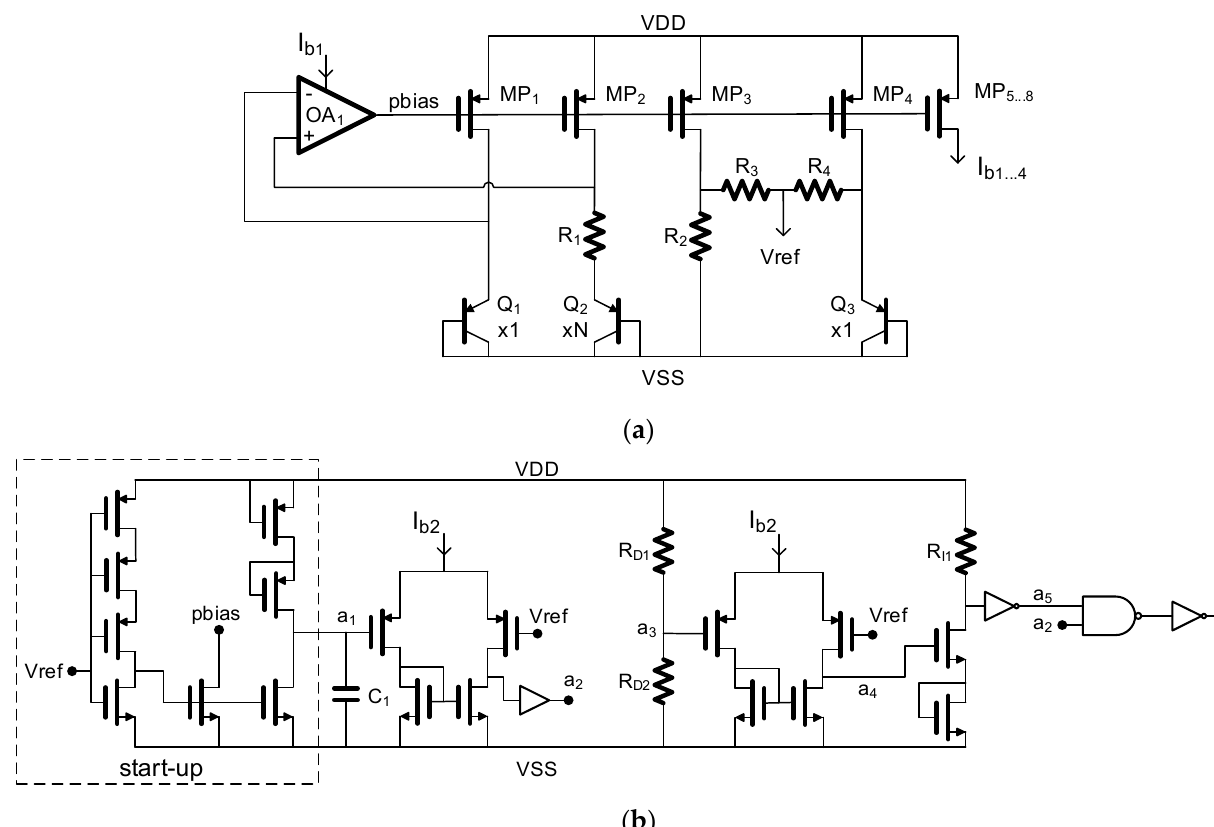
Figure 3. BGR#1 in FDSOI 22 nm and 1.8 V supply voltage ( a ) core circuit and ( b ) RI circuit.